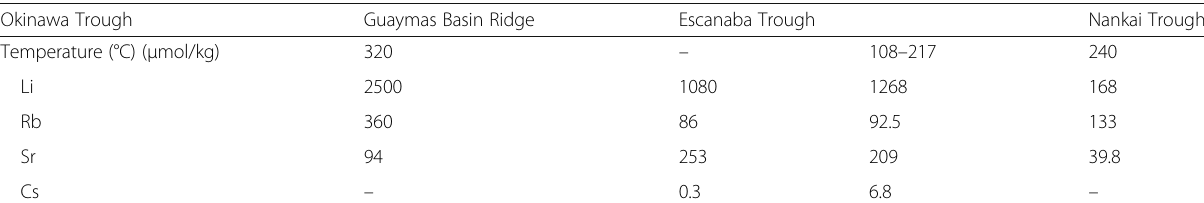
Table 2 Comparison of trace element composition in Okinawa Trough, Guaymas Basin (Gamo 1995), Escanaba Trough (Campbell et al. 1994), and Nankai Trough (Nishio et al. 2015) Okinawa Trough